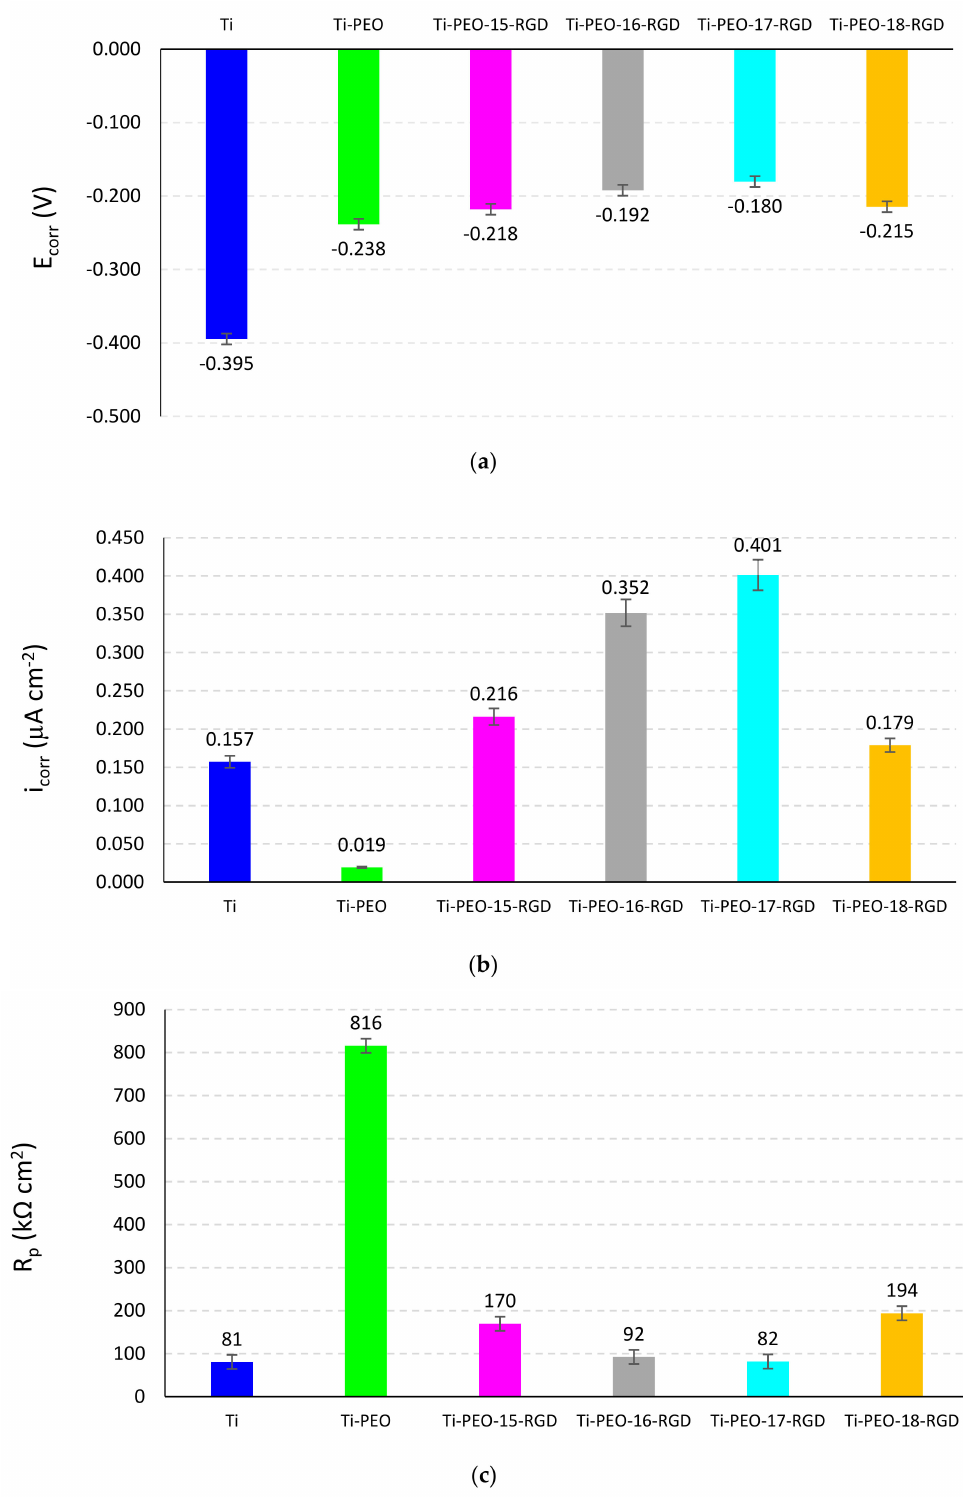
Figure 5. Electrochemical properties in Ringer’s solution for the Ti samples, with PEO coating, and RGD modification: ( a ) Corrosion potential E corr ; ( b ) Corrosion current i corr ; ( c ) Polarization resistance R p